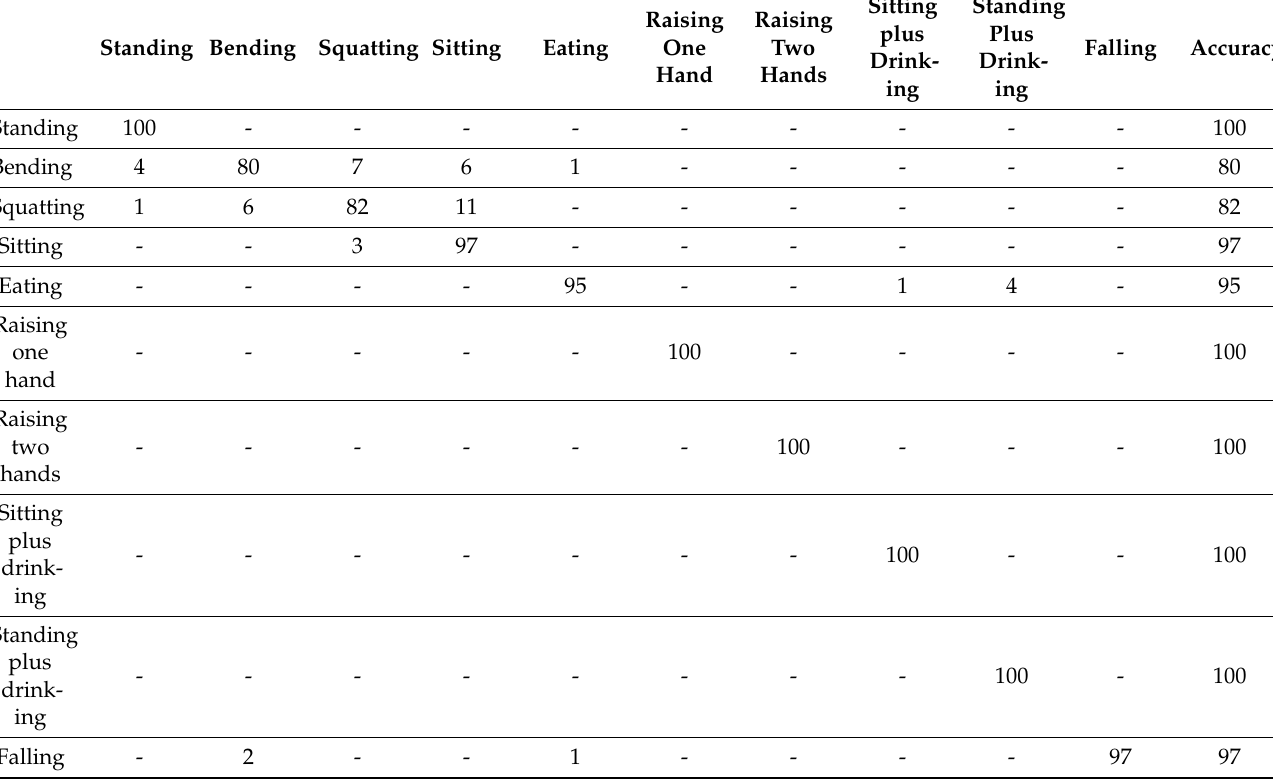
Table 1. Evaluation result for DNN-based